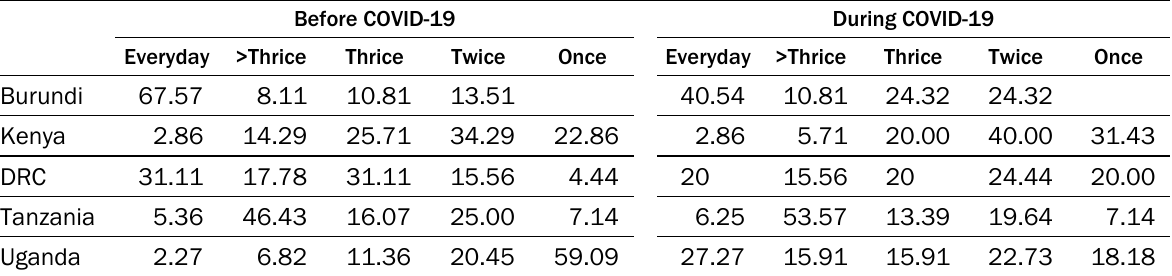
During COVID-19